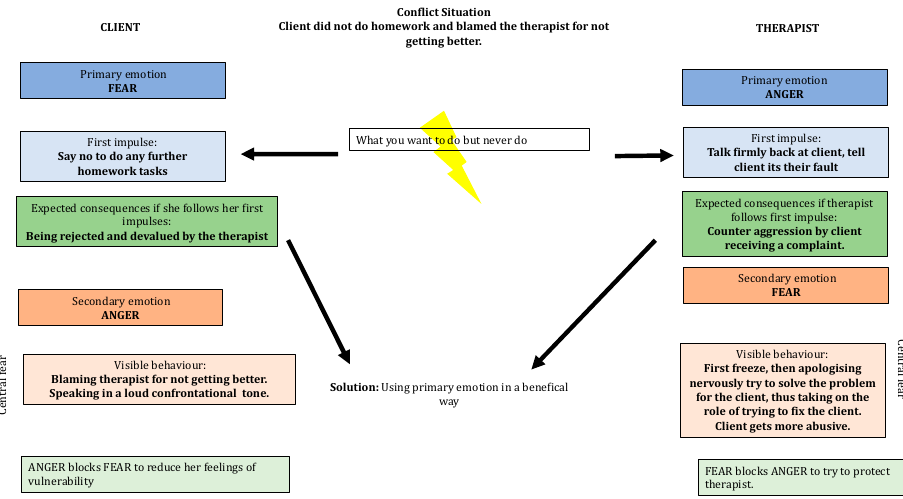
Figure 5. Interacting reaction chains, highlighting potential intervention points for change in the interaction.